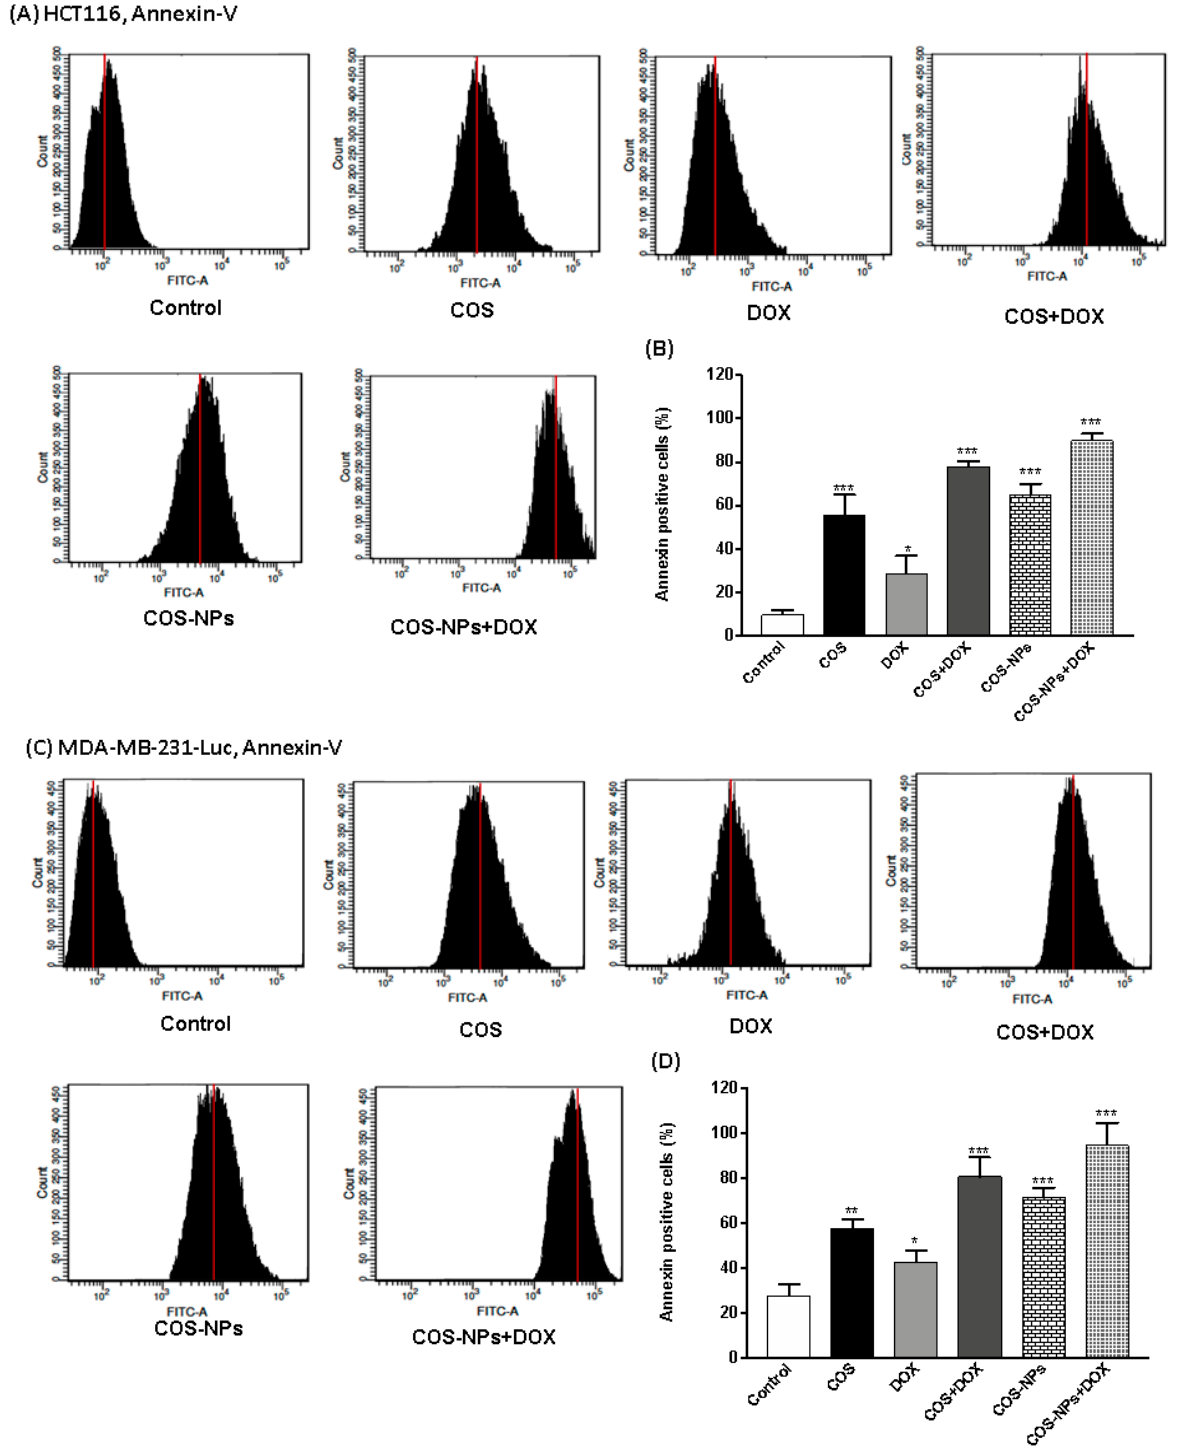
Figure 6. Annexin-V positive HCT116 and MDA-MB-231-Luc cells treated with costunolide (COS), doxorubicin (DOX), costunolide + doxorubicin (COS+DOX), costunolide-nanoparticles (COS-NPs), and costunolide-nanoparticles + doxorubicin (COS-NPs+DOX). ( A ) Flow cytometric analysis of HCT116, ( B ) Annexin-positive HCT116 cells percentages, ( C ) Flow cytometric analysis of MDA-MB-231-Luc, and ( D ) Annexin-positive MDA-MB-231-Luc cells percentages treated with costunolide (COS), doxorubicin (DOX), costunolide + doxorubicin (COS+DOX), costunolide-nanoparticles (COS-NPs), and costunolide-nanoparticles + doxorubicin (COS-NPs+DOX). Values are presented as mean ± SD. * p < 0.05, ** p < 0.01 and *** p < 0.001.